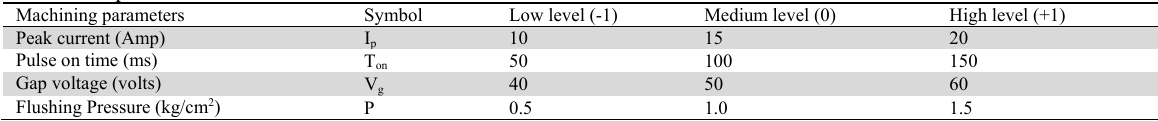
Levels of input factors Machining parameters